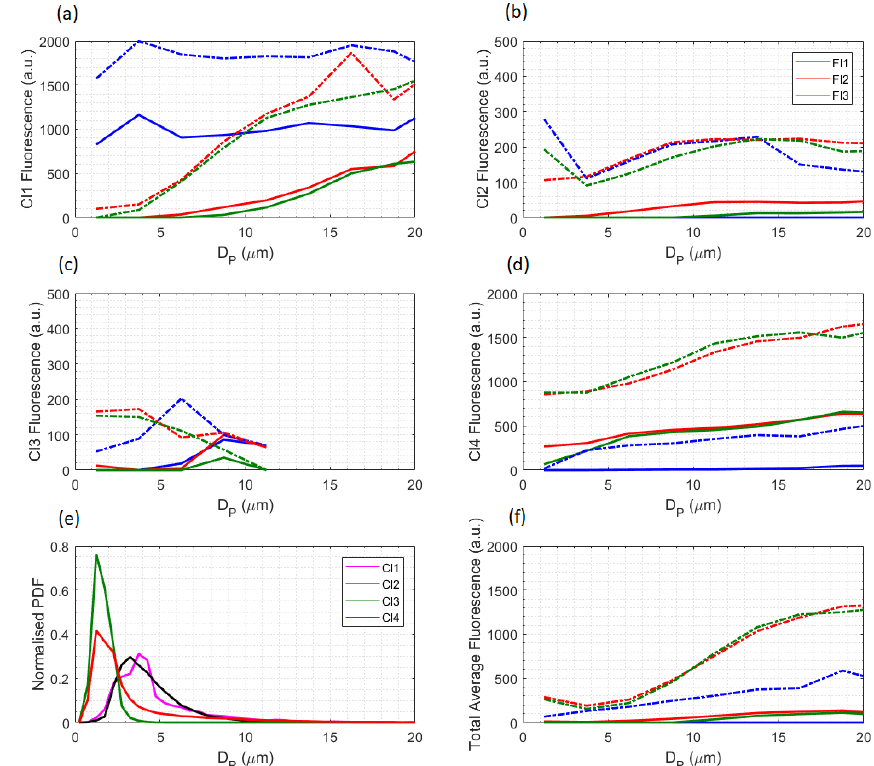
Figure 2. Solid lines represent the median fluorescence of particles as a function of size, instrument channel and cluster. Dotted lines represent 95th percentile values. The 2.5µm bins have been used for all fluorescence traces. Panels (a–d) represent Clusters 1–4, respectively, while panel (e) represents the normalised size distribution of fluorescent particles across all clusters, using 0.5µm bins. Panel (f) represents the average across all fluorescent particles.